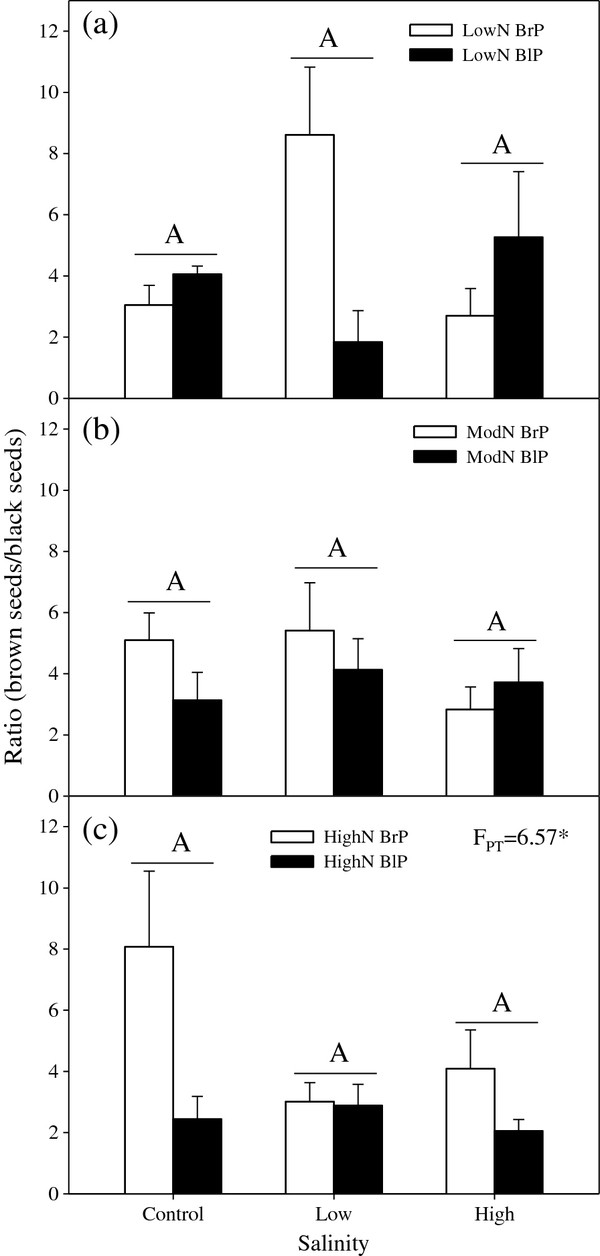
Effects of plant type and salinity on ratio (number of brown seeds/number of black seeds) per plant for different nutrient availabilities. (a) Low nutrient, (b) Moderate nutrient, (c) High nutrient. N: Nutrient; BrP: Plant grown from brown seed; BlP: plant grown from black seed. F-values are given when significance levels are reached (PT: plant type; * P < 0.05). Bars with the same uppercase letters are not significantly different at P < 0.05 according to the Tukey’s test.